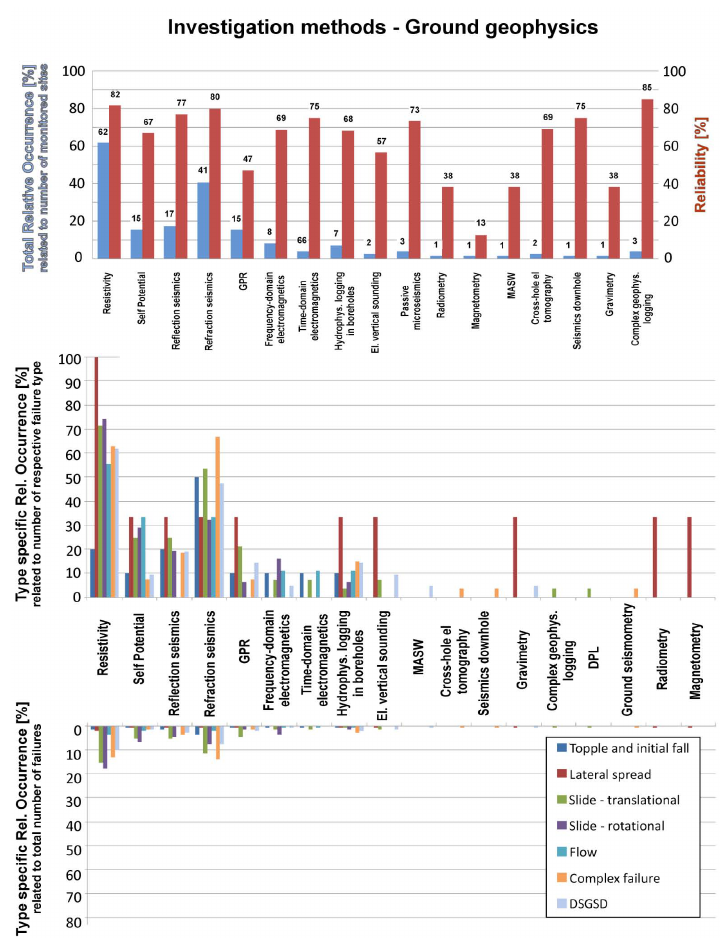
Fig. 7. Review of total relative occurrence, reliability and type-specific relative occurrence of the geophysical methods applied for the investigation of the monitored landslide